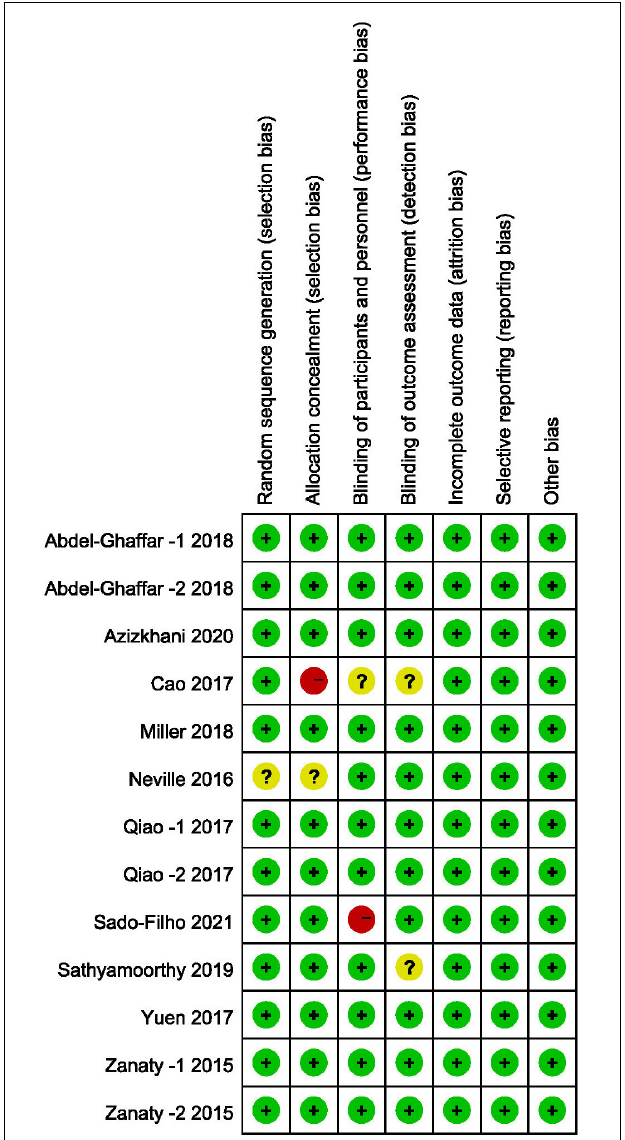
FIGURE 3 | Risk of bias